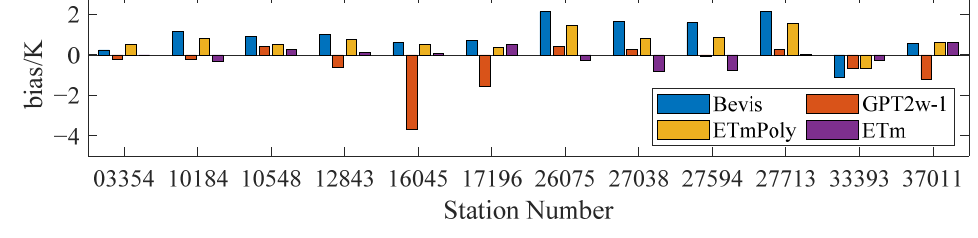
11 of 18 Figure 7. Results of the bias and RMS of the four Tm models at different latitude ranges. 3.2. Performance Analysis of Different Tm Models at Non-modeling Stations in 2021 In Section 3.1, we analyzed the prediction performance of the observations of 48 mod- eling stations in 2021, where the ETm model was established and concluded that the ETm model had a good performance at modeling stations. Then, we considered whether other sites over Europe have good generalization in addition to these sites for model construc- tion. In this section, to further verify the accuracy performance of the model at the stations that did not participate in the modeling over Europe, we selected 12 evenly distributed sites over Europe (the non-modeling stations are shown in the blue triangle in Figure 1), which are different from the 48 modeling sites, and used the ETm model to predict their Tm values in 2021. Three traditional models were used to calculate Tm values for com- parison, and their respective bias and RMS values were counted (see Table 3 and Figure 8). Table 3. RMS and bias values of four Tm Models in 2021 using 12 non-modeling stations. Model